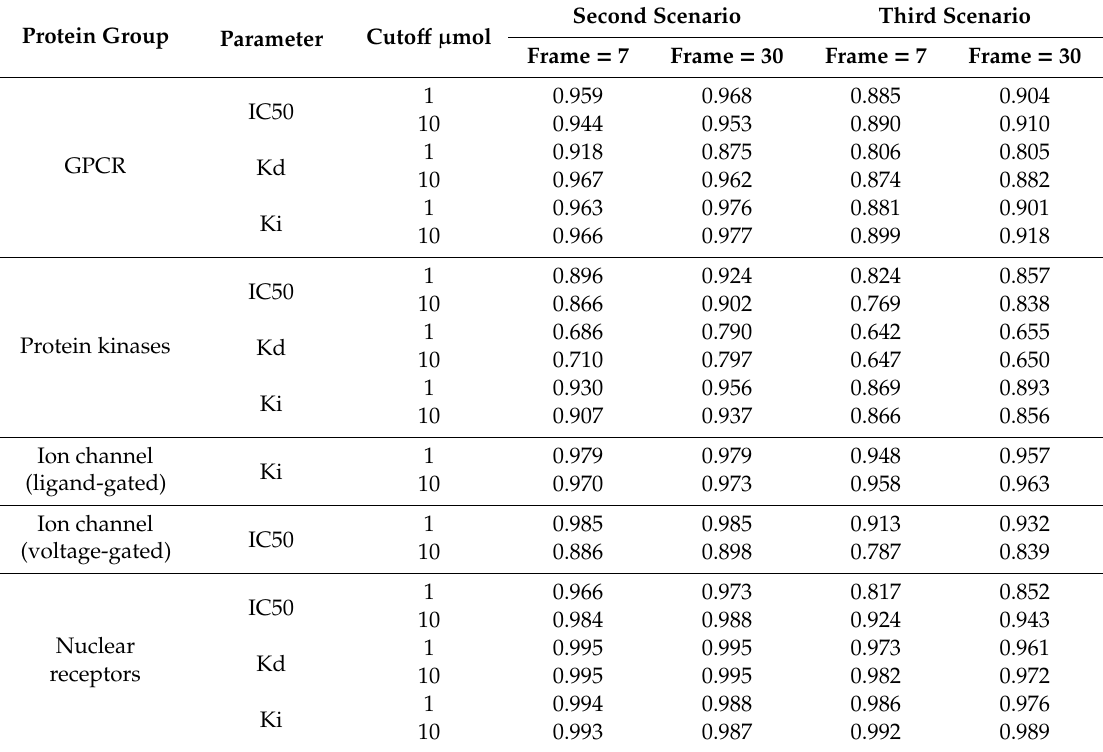
Table 3. Predictive accuracy (AUC) for target a ffi nities to ligands (second scenario) and both uncharacterized interactors (third